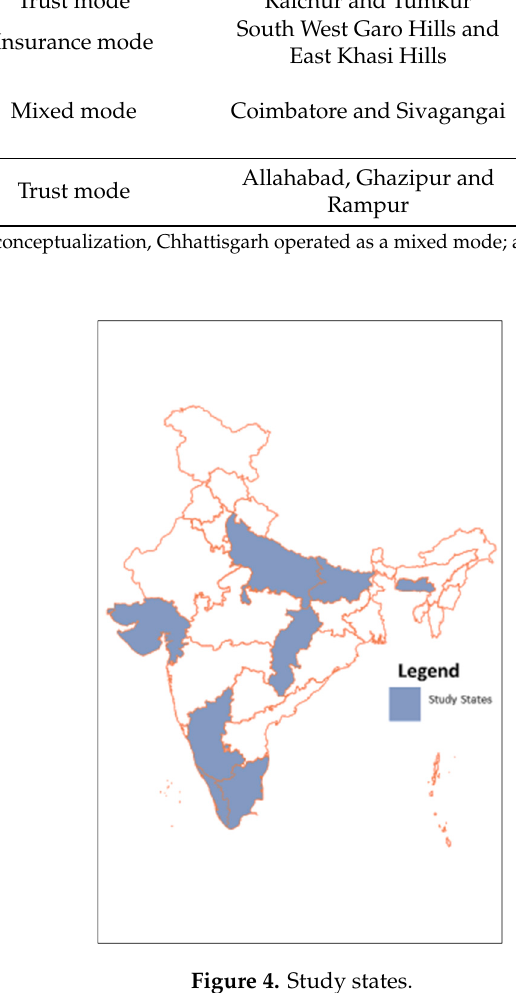
Figure 4. Study states.